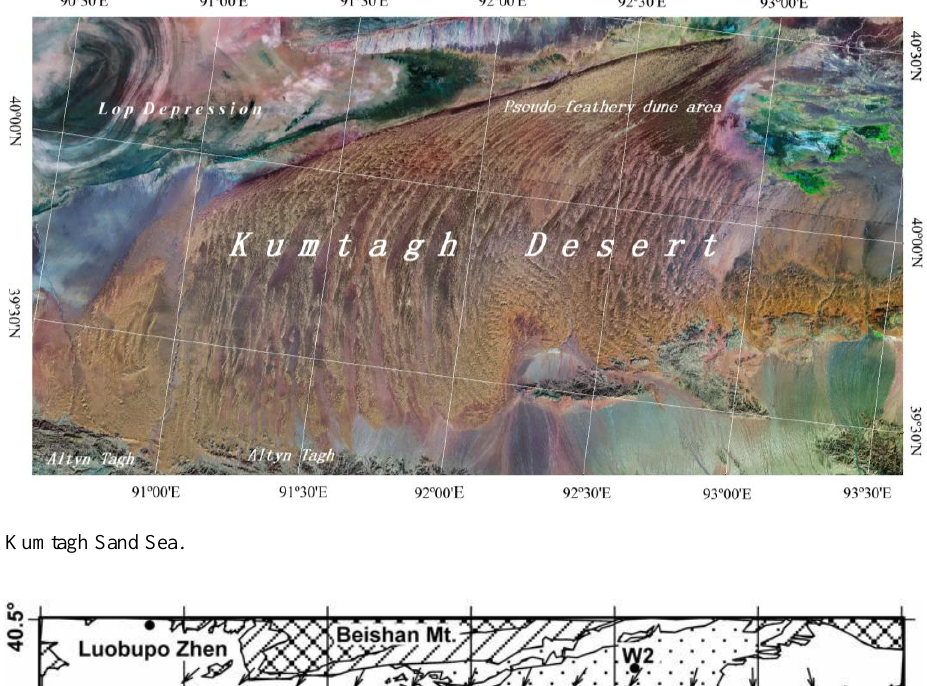
Figure 1 Map of the Kumtagh Sand Sea